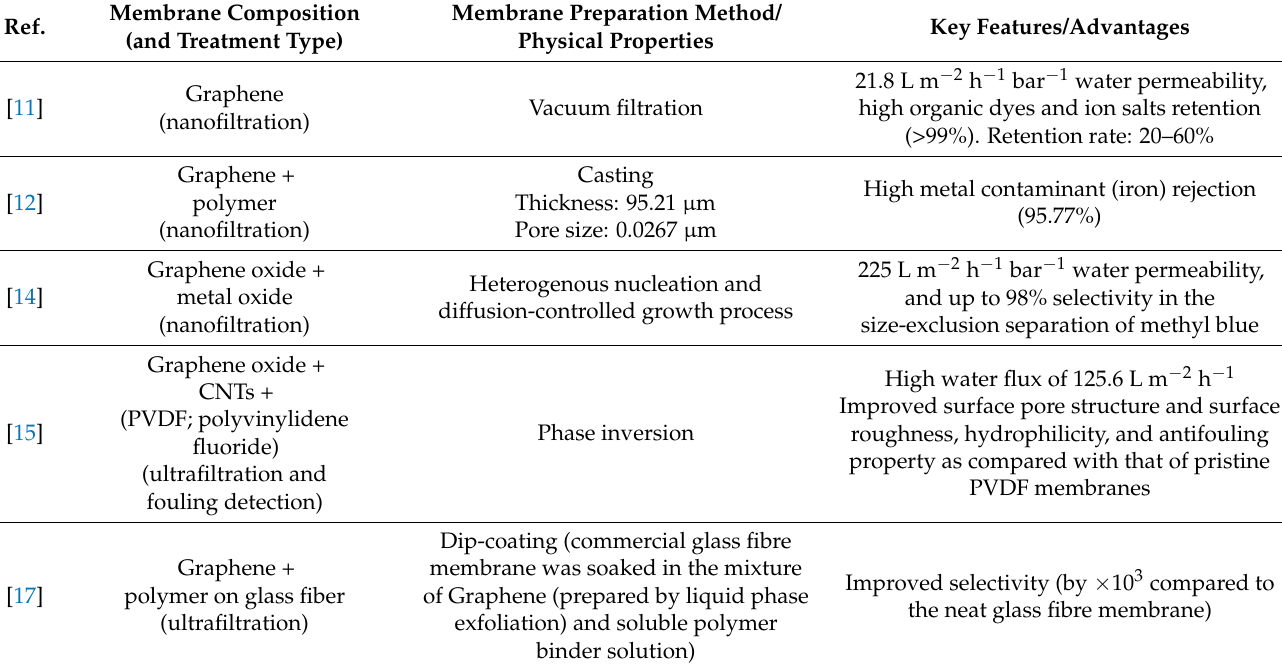
Table 2. Advances in graphene nanocomposite membranes and properties.